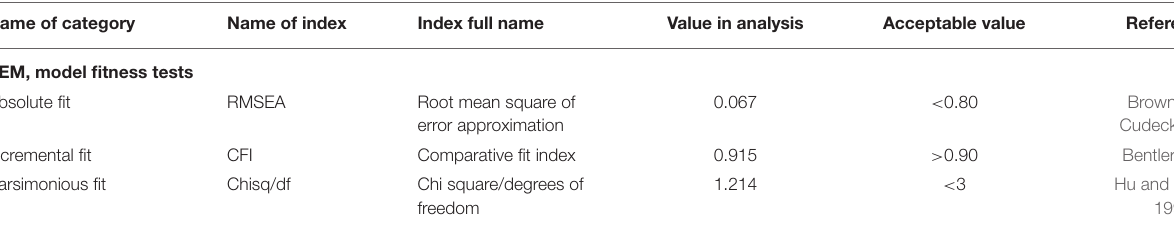
TABLE 5 | Structural equation modeling analysis.